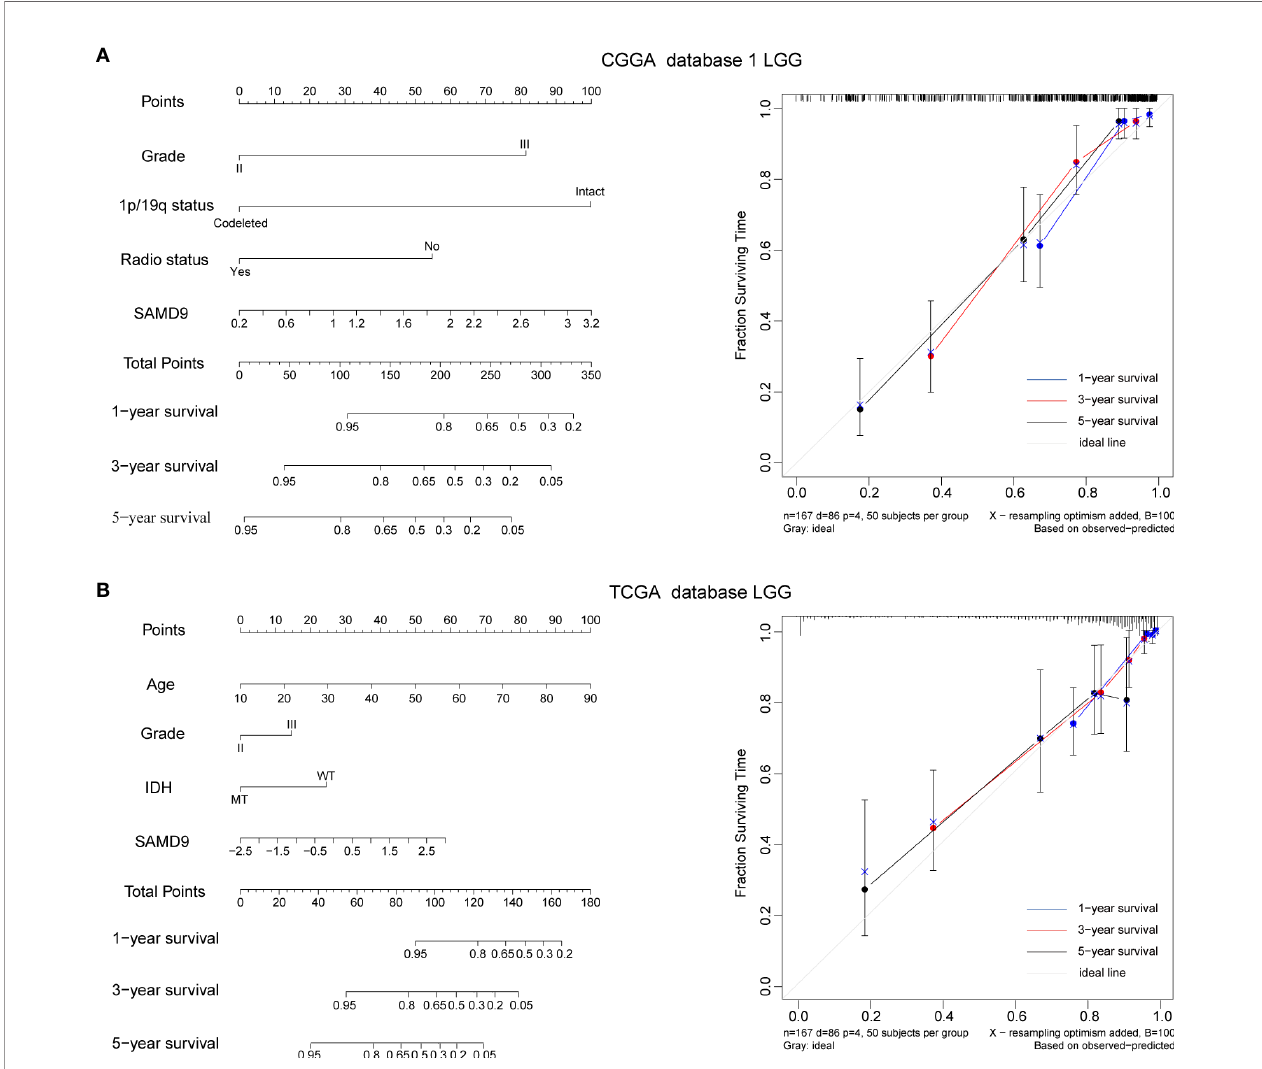
FIGURE 5 | Nomogram prediction model for overall survival (OS) and other integrated risk factors. (A) A nomogram was developed by integrating the SAMD9 expression with the clinicopathologic features, grade, 1p/19q codeletion status, radiotherapy status in the CGGA database 1 (left). Calibration plot of nomogram for predicting OS at 1- (blue line), 3- (red line) and 5- (black line) years, ideal line as control (white line) in the CGGA database 1 (right). (B) A nomogram was developed by integrating the SAMD9 expression with the clinicopathologic features, age, grade, IDH status (MT, mutant. WT, wild type.) in the TCGA database (left). Calibration plot of nomogram for predicting OS at 1- (blue line), 3- (red line) and 5- (black line) years, ideal line as control (white line) in the TCGA database LGG